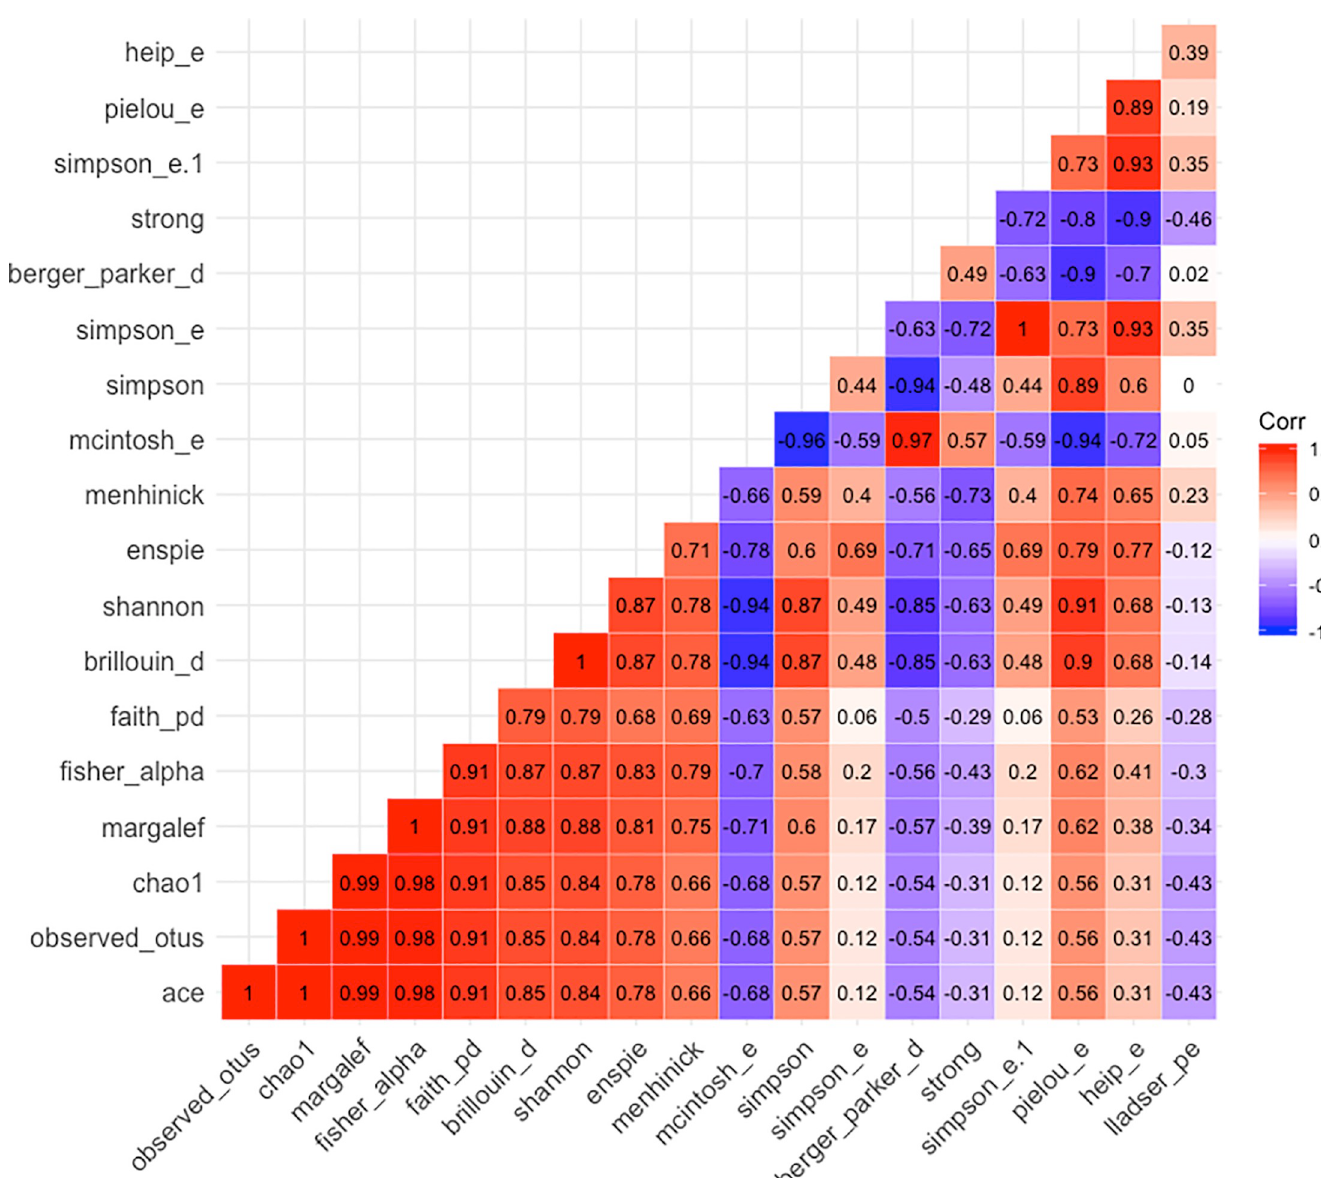
Fig 1. Correlations among alpha diversity indices. Correlations among all calculated alpha diversity indices are displayed. Positive correlations displayed in blue, and negative correlations displayed in red. Stronger correlations denoted by greater opaqueness. https://doi.org/10.1371/journal.pone.0229204.g001 In addition to examining correlations among the set of alpha diversity indicator variables, the distributions of the indicator variables were also examined in order to determine viability for inclusion in the EFA. Specifically, skewness and kurtosis were evaluated for each alpha diversity indicator variable. At this stage, 4 metrics were excluded on the basis of demonstrat- ing elevated skewness/kurtosis, as evidenced by their skewness and kurtosis: Simpson (skew- ness = -5.03, kurtosis = 31.97), Pielou e (skewness = -1.84, kurtosis = 7.05), Mcintosh e (skewness = 2.71, kurtosis = 12.12), and Berger Parker d (skewness = 2.78, kurtosis = 11.54). Exploratory factor analysis. The final set of viable alpha diversity indicator variables were included in an EFA (see Table 3). In order to determine the likely number of factors